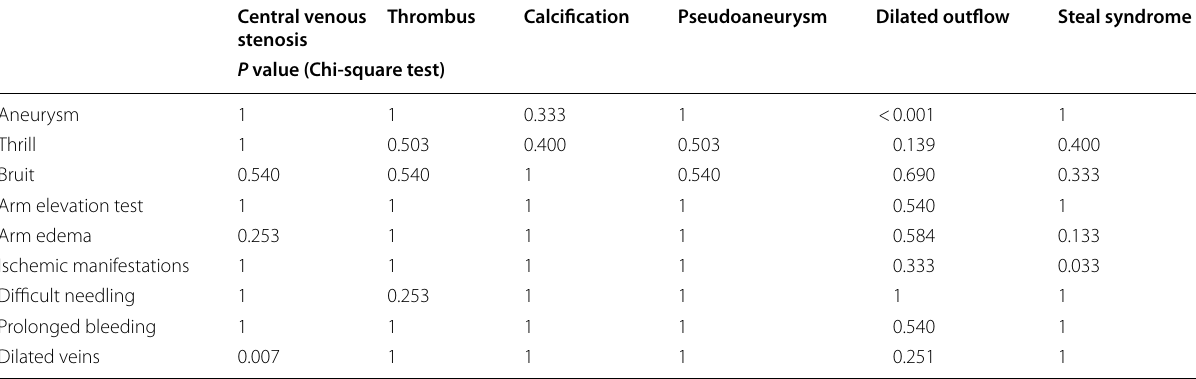
Table 6 Association between the clinical examination results and CDU AVF